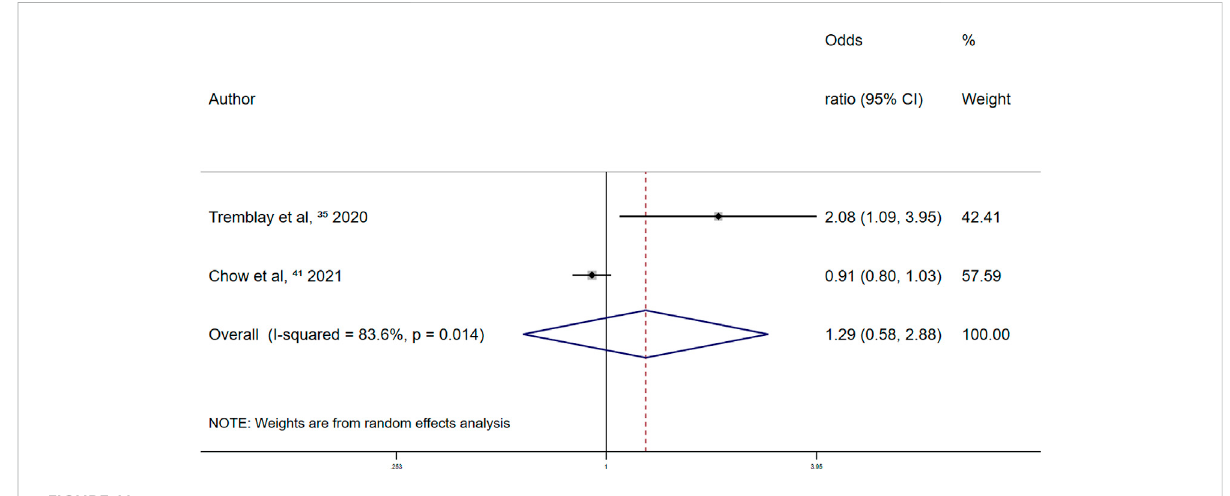
FIGURE 11 Summary odds ratio of thrombotic events for other antiplatelet drugs use in retrospective